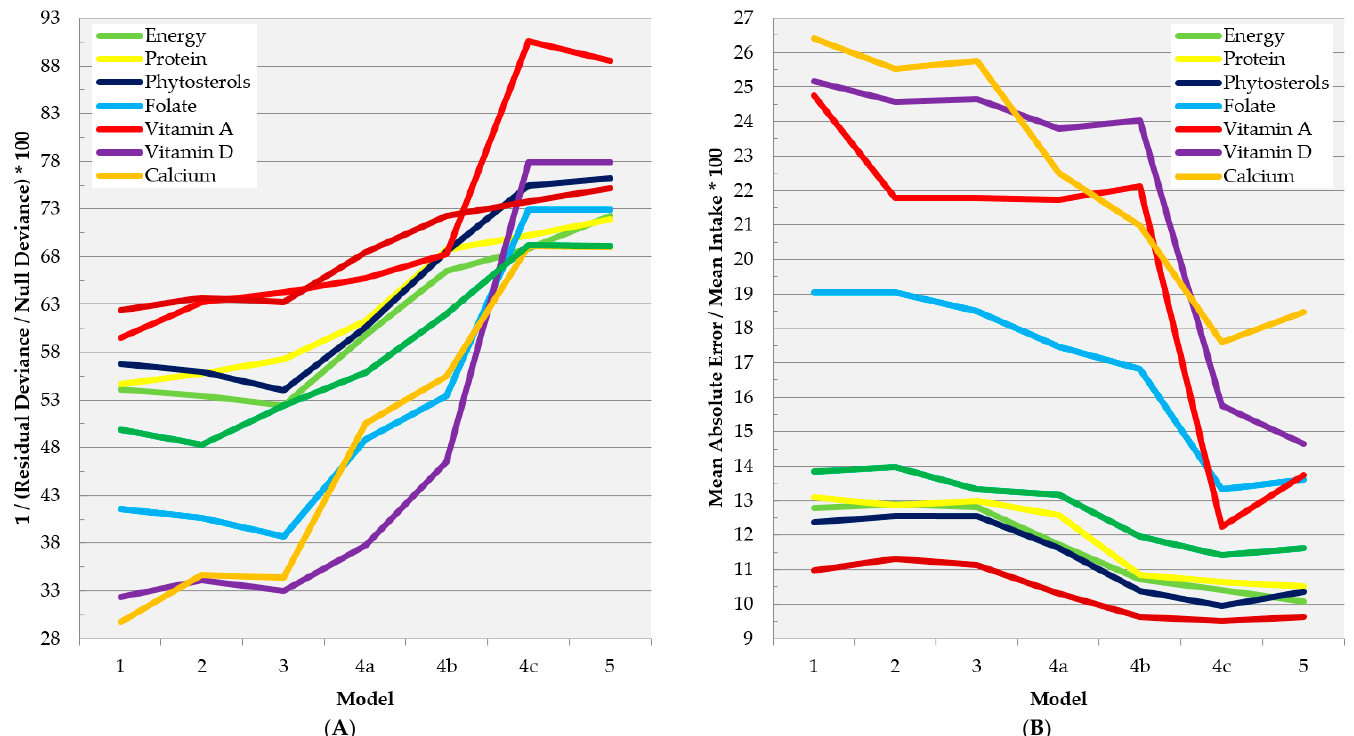
Figure 4. In-sample fit statistics for increasingly complex predictive models of individuals’ dietary intakes of selected nutrients in the FCS-24 (Aim 4). ( A ) percentage of deviance explained; ( B ) mean absolute bias (proportional to mean observed dietary intake). See Table 4 for detailed descriptions of models 1–5. Brief description of variable categories considered for selection in each model: (1) Household and individual demographic, socioeconomic, and lifestyle characteristics; (2) Model 1 variables + quantitative total household consumption of food groups and nutrients; (3) Model 2 variables + individuals’ self-evaluation of nutrition knowledge and its application to their lives; (4a) Model 3 variables + cursory qualitative 24-h recall and assessment of eating behaviors; (4b) Model 3 variables + cursory semiquantitative 24-h recall and assessment of eating behaviors; (4c) Model 3 variables + detailed semiquantitative 24-h recall; (5) Model 4 variables + measured anthropometry. Abbreviation: FCS-24 (nested 24-h recall of the 2013 Food Consumption Survey).